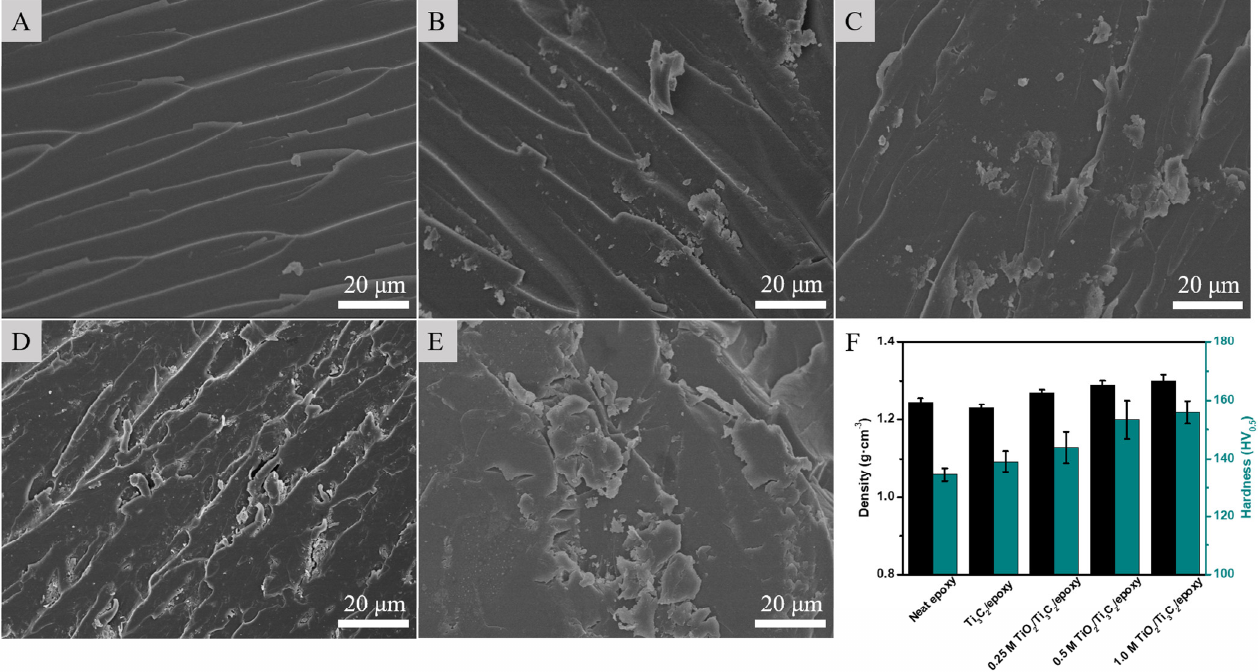
Figure 4. SEM images of fracture surfaces of neat epoxy ( A ), Ti 3 C 2 /epoxy ( B ), 0.25 M TiO 2 /Ti 3 C 2 /epoxy ( C ), 0.5 M TiO 2 /Ti 3 C 2 /epoxy ( D ), 1.0 M TiO 2 /Ti 3 C 2 /epoxy ( E ) nanocomposites at 0.5% mass fraction. Density and hardness ( F ) of neat epoxy and TiO 2 /Ti 3 C 2 /epoxy nanocomposites at 0.5% mass fraction.